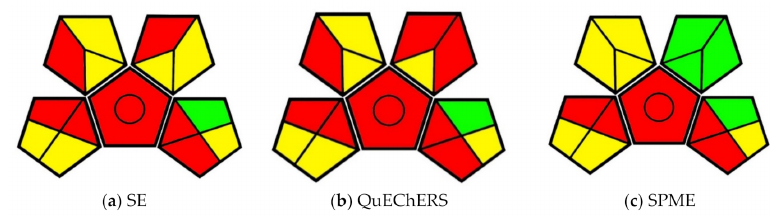
Figure 5. ( a ) GAPI evaluation pictogram for the solvent extraction (SE) method; ( b ) GAPI evaluation pictogramfortheQuEChERSmethod; ( c )GAPIevaluationpictogramforthesolid-phasemicroextraction (SPME) method from Khaled et al.,